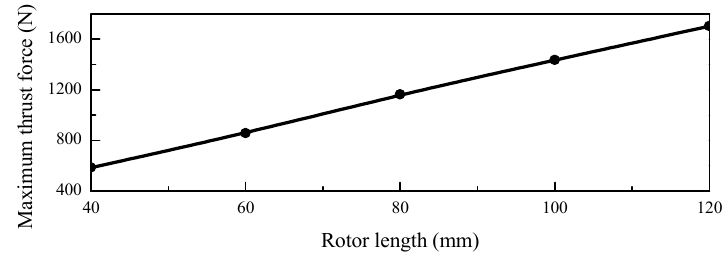
Figure 11. Variation in the maximum thrust force with different rotor lengths.